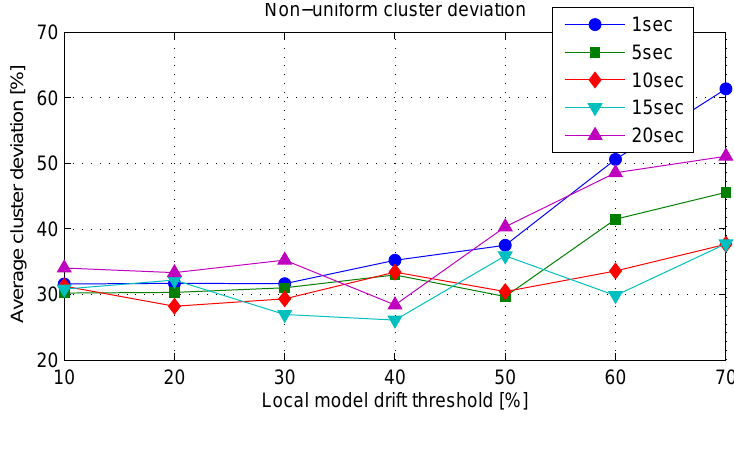
Figure 12. Average cluster deviation for non-uniform cluster